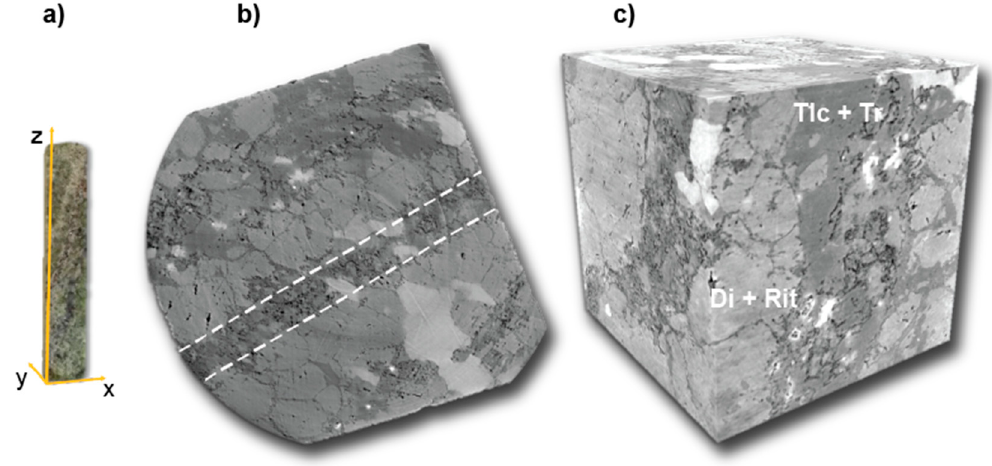
Figure 9. Sample 4 (S4). ( a ) Sample cut for tomographic scanning; ( b ) example of one single slice generated (1800 scans in total); ( c ) volume rendering (7.4 mm 3 ) obtained by synchrotron radiation X-ray microtomography (rendering performed using the commercial software VGStudio Max 2.0).